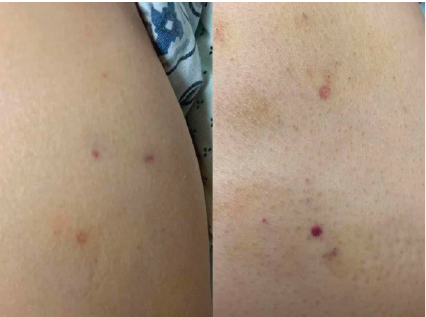
Figure 1: Bleeding point.